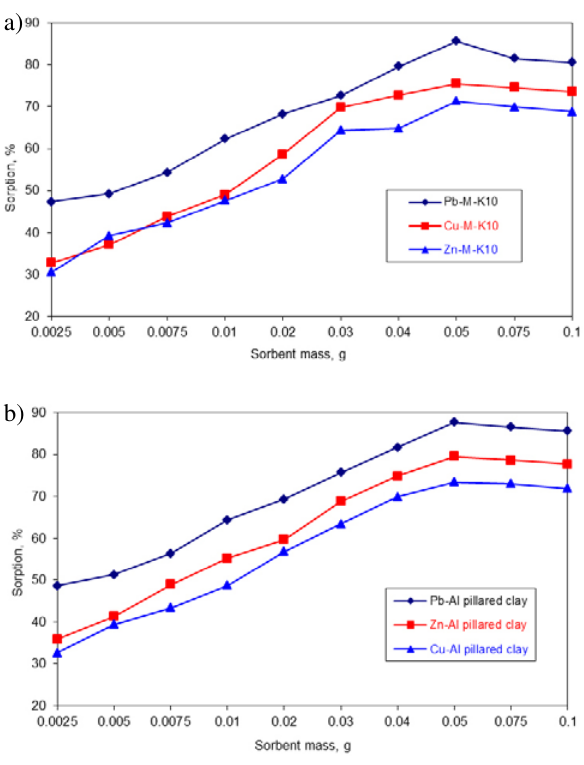
Fig. 2. Effect of adsorbent mass on adsorption process of Pb 2+ , Cu 2+ and Zn 2+ onto montmorillonite-K10 (a) and Al-pillared clay